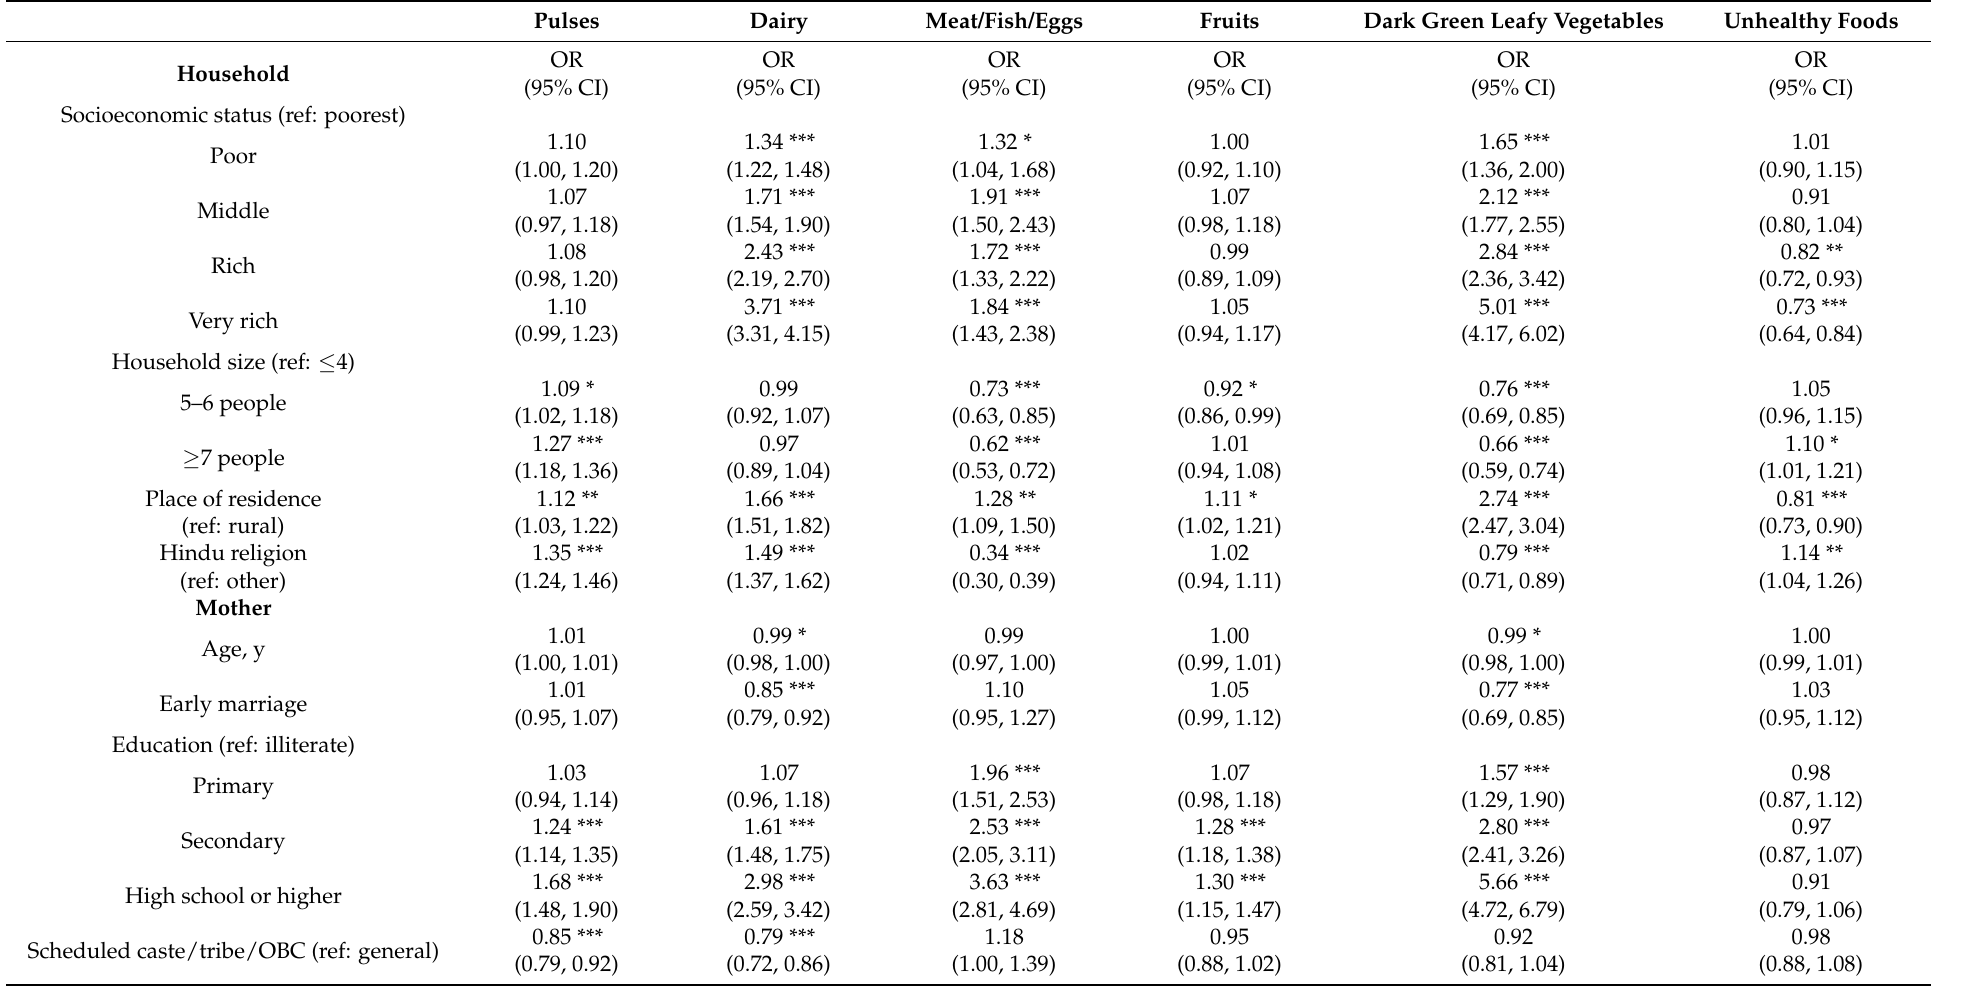
Table 2. Factors associated with dietary intake among pregnant women, NFHS-4 data 2015–16. Pulses Dairy Meat/Fish/Eggs Fruits Dark Green Leafy Vegetables Unhealthy